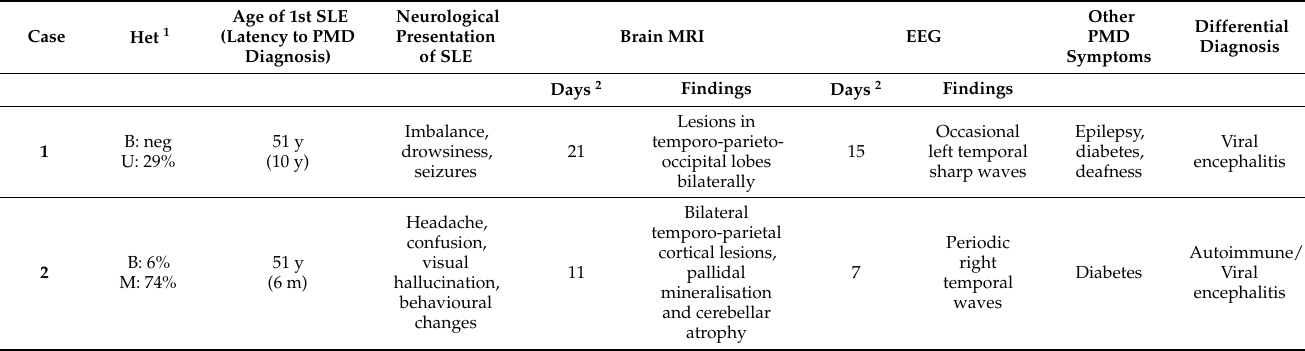
Table 1. Clinical, radiological, and molecular characteristics of four subjects with stroke-like episodes caused by the m.3243A > G mutation in MT-TL1